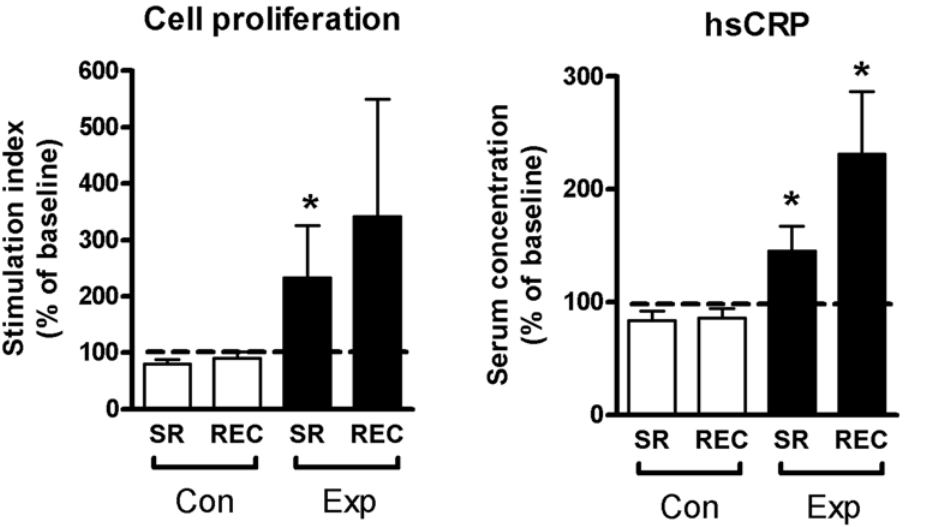
Figure 2. PBMC proliferation and hs-CRP. Proliferation of PBMC after stimulation with phytohaemagglutinin (PHA, 45 m g/mL) and high sensitivity C-reactive protein (hs-CRP) concentrations in plasma. SR=sleep restriction, REC=recovery, Con=control group, Exp=sleep restriction group. Data are expressed as percentages of participant’s individual baseline values (mean 6 SEM). * p , 0.05.